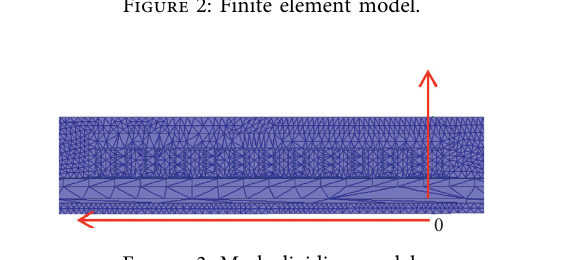
Figure 2: Finite element model.